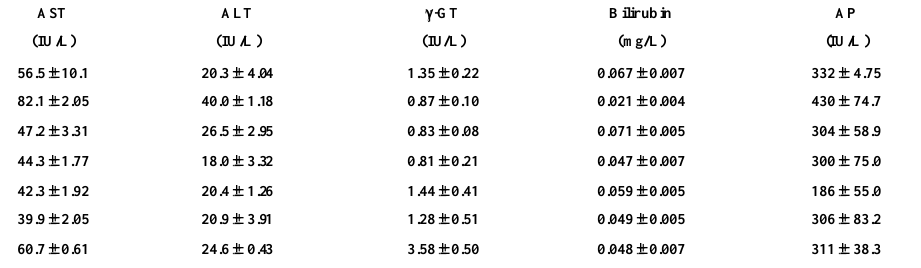
Table 1. Measurement of the hepatic activity of four enzymes and bilirubin concentrations in serum of normal, diabetic, and diabetic treated with total oil, polar and neutral lipid fractions of Nigella sativa seeds, in rats. Group I: normal rats, Group II: diabetic rats, Group III: diabetic rats treated with 100mg/kg bw/day of total oil of Nigella sativa seeds, Group IV: diabetic rats treated with 100mg/kg bw/day of polar fraction of Nigella sativa seeds total oil, Group V: diabetic rats treated with 100mg:kg bw/day of neutral fraction total oil of Nigella sativa seeds, Group VI: diabetic rats treated with 25mg/kg bw/day of thymoquinone, Group VII: diabetic rats treated with 25mg/kg bw /day of metformin. Each group contains 7 rats. AST = aspartate transaminase, ALZ = alanine transaminase, g -GT = gamma-glutamyl transpeptidase, AP =